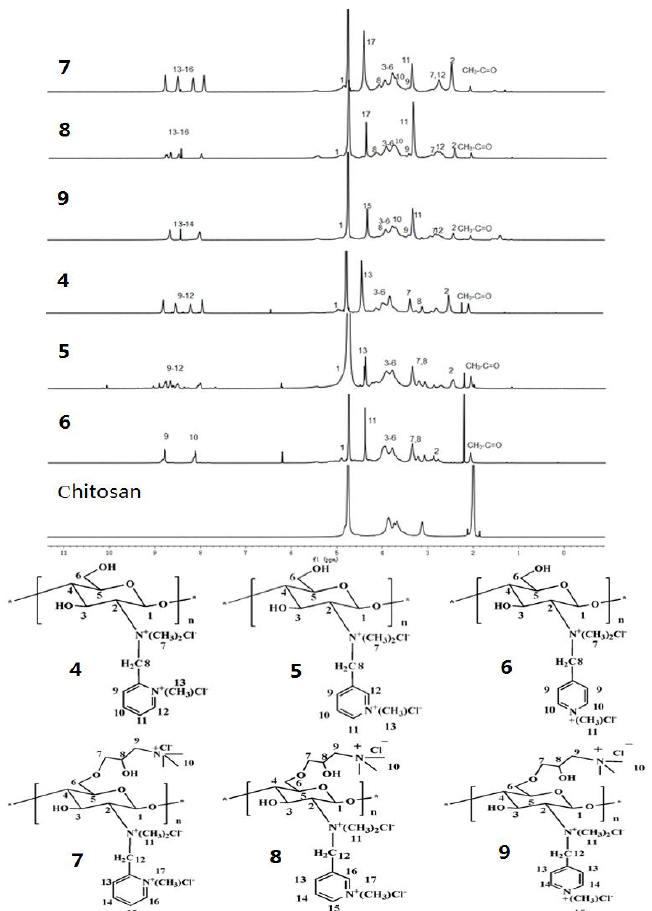
Figure 2. 1 H-NMR spectra of chitosan, 4 , 5 , 6 , 7 , 8 and 9 .